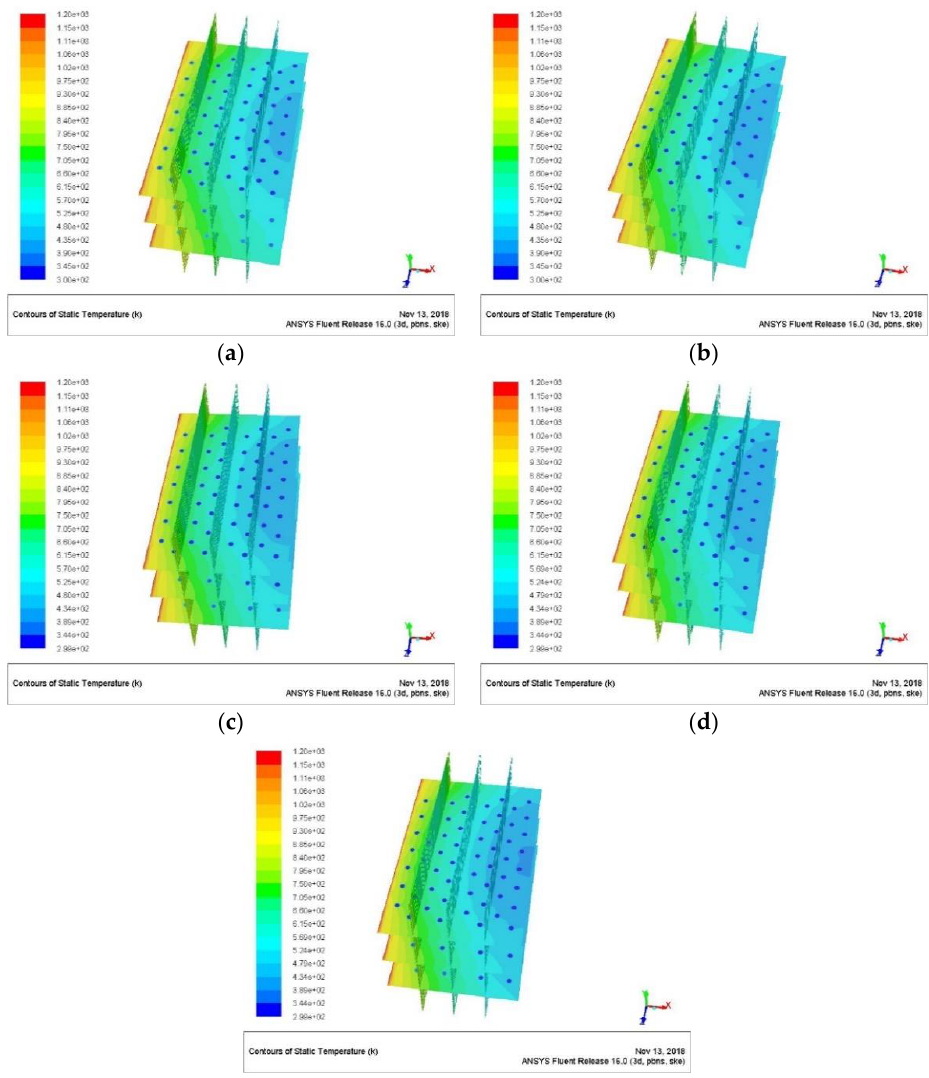
Figure 10. Temperature distribution under different cooling water flow rates. ( a ). Cooling water flow rate was 2.6 m 3 /h. ( b ) Cooling water flow rate was 3.5 m 3 /h. ( c ) Cooling water flow rate was 4.3 m 3 /h. ( d ) Cooling water flow rate was 5.2 m 3 /h. ( e ) Cooling water flow rate was 6.1 m 3 /h.